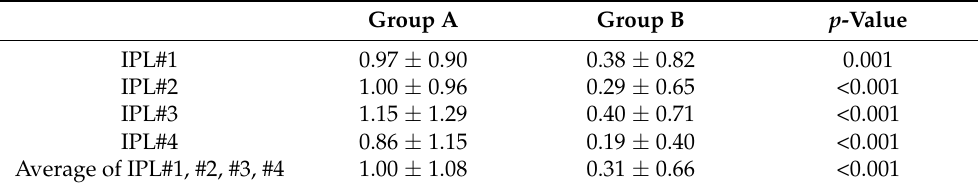
Table 4. Visual analog scale scores for each intense pulsed-light treatment.